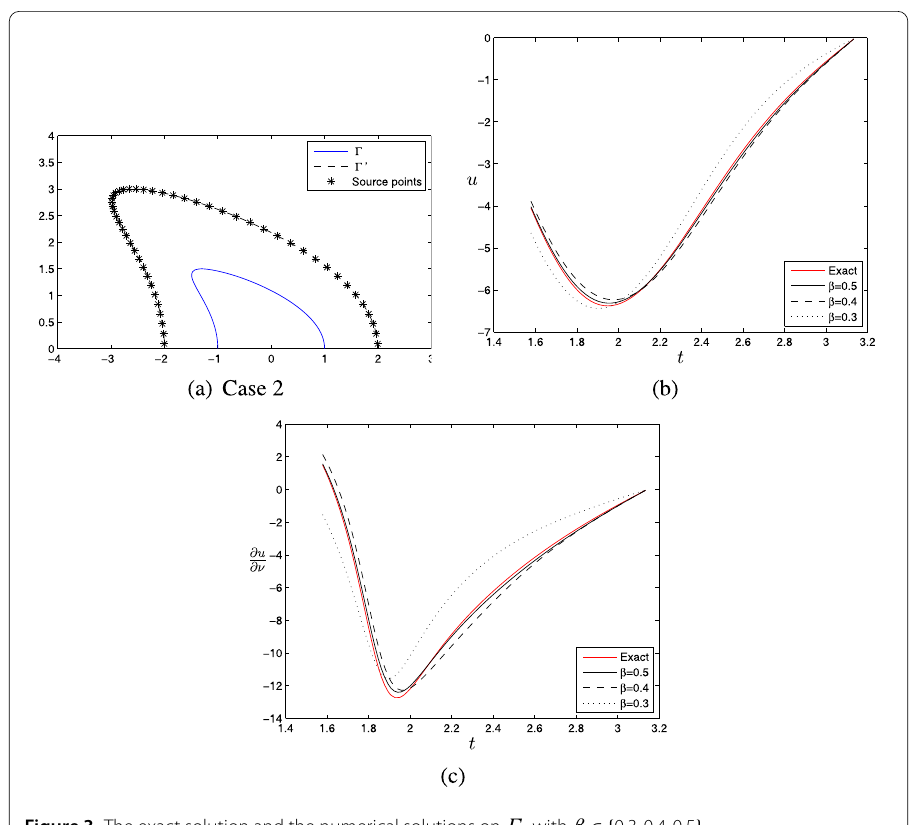
Figure 3 The exact solution and the numerical solutions on Γ 2 with β ∈ { 0.3,0.4,0.5 }